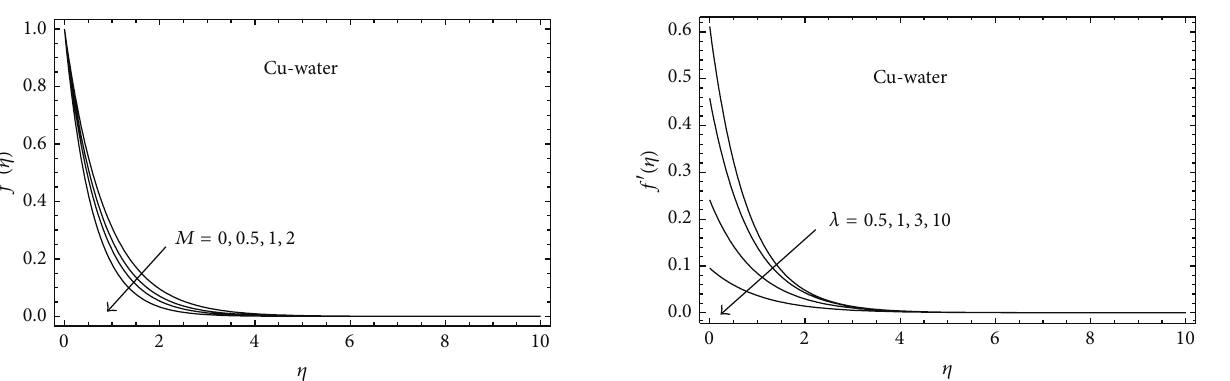
Figure 4: Effect of 𝜆 on velocity distribution 𝑓 󸀠 (𝜂) for Pr = 6.2 , 𝑀 = 1 , and 𝜙 = 0.1 .